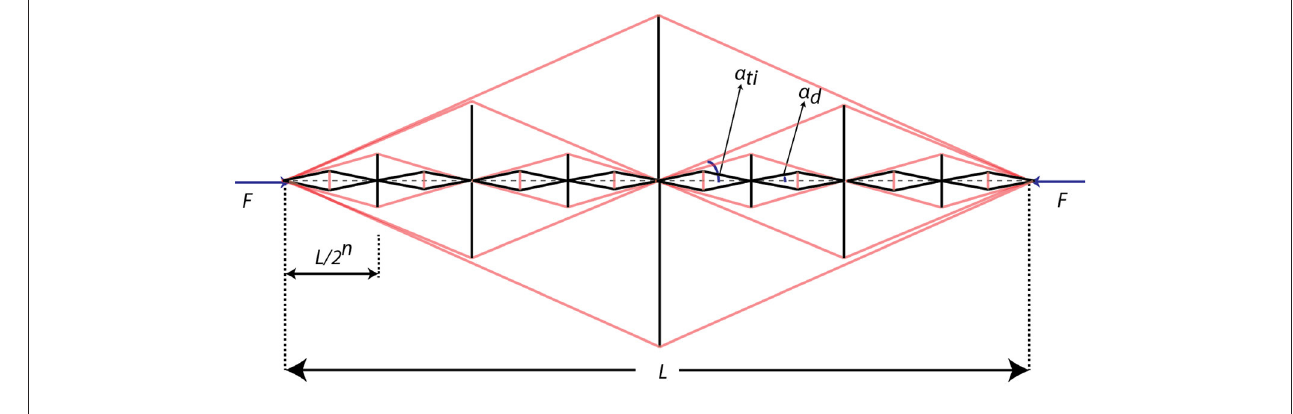
FIGURE 12 | TD-bar configuration.